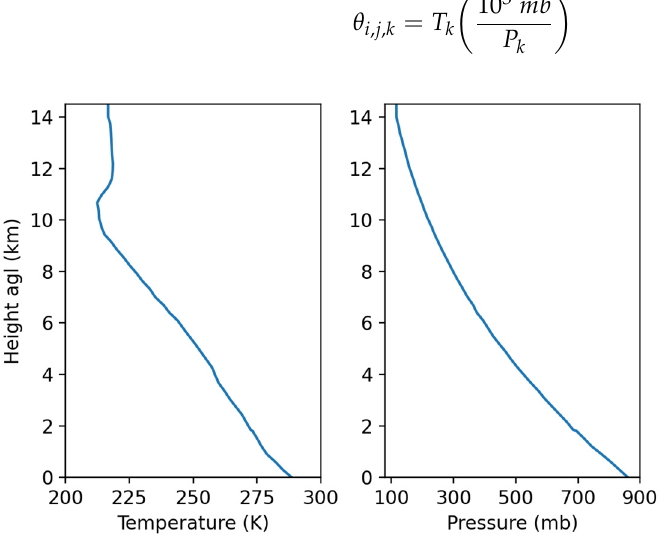
Figure 12. Ambient meteorology utilized to simulate the Dixie test. The ambient temperature and pressure vertical profiles are shown with respect to height above ground level (agl).